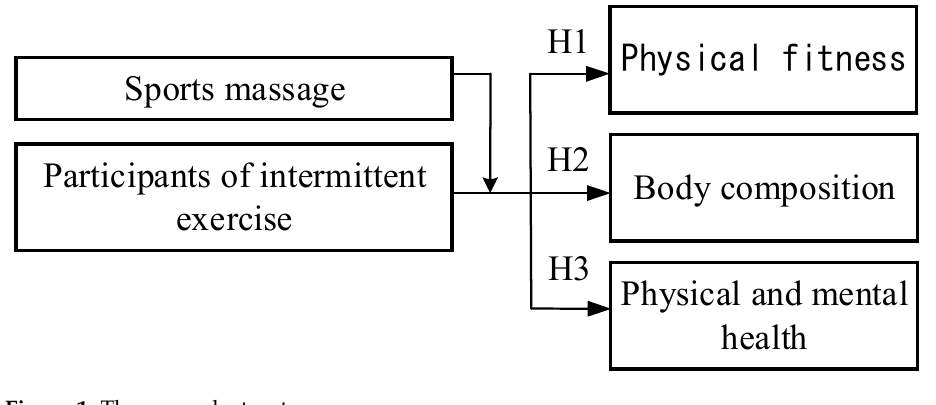
Figure 1. The research structure.